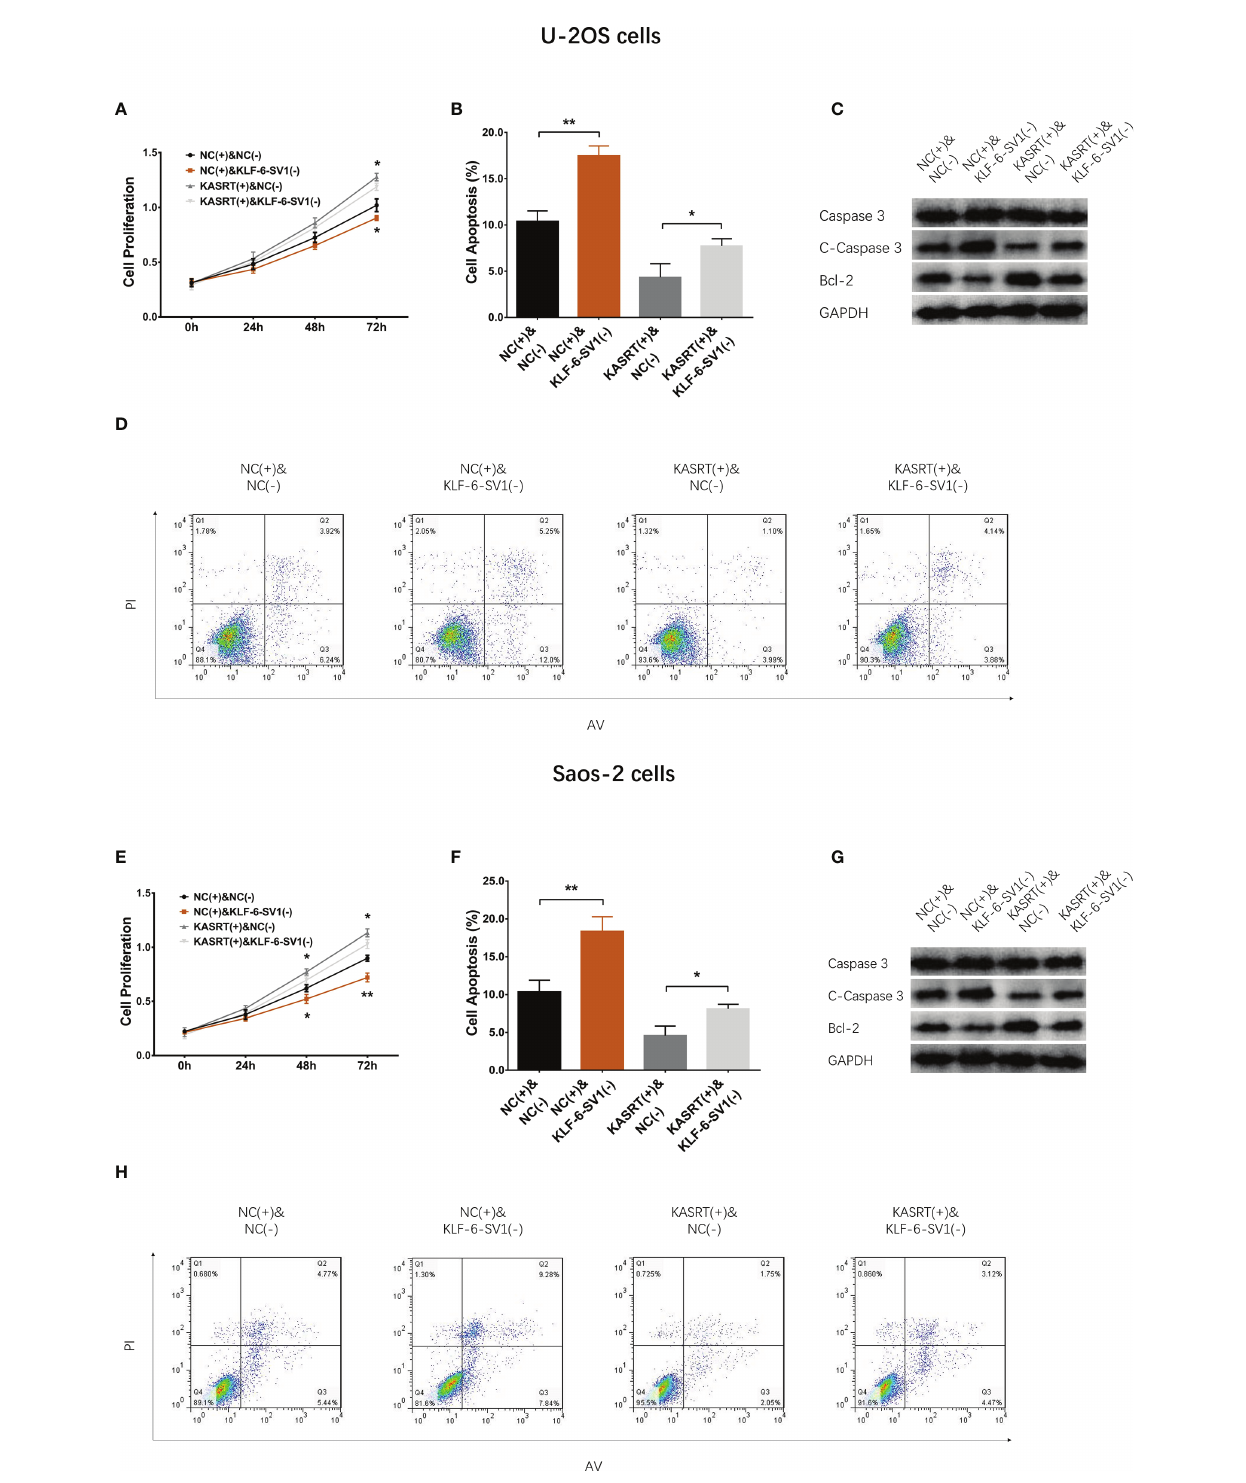
FIGURE 6 | Cell proliferation and apoptosis in compensatory experiments. In compensatory experiments, cell proliferation (A) , cell apoptosis rate (B) , pro-/anti- apoptotic marker expression (C) , and AV/PI images (D) among groups in U-2OS cells; cell proliferation (E) , cell apoptosis rate (F) , pro-/anti-apoptotic marker expression (G) , and AV/PI images (H) among groups in Saos-2 cells. *P < 0.05, **P <